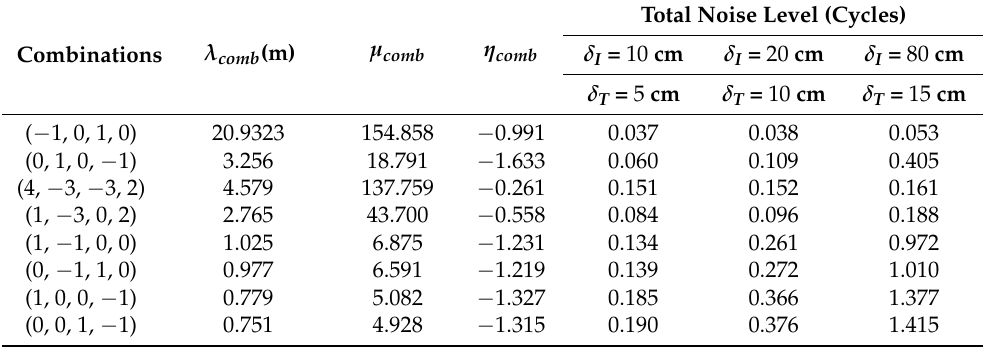
Table 2. Total noise level for commonly used combinations under different error